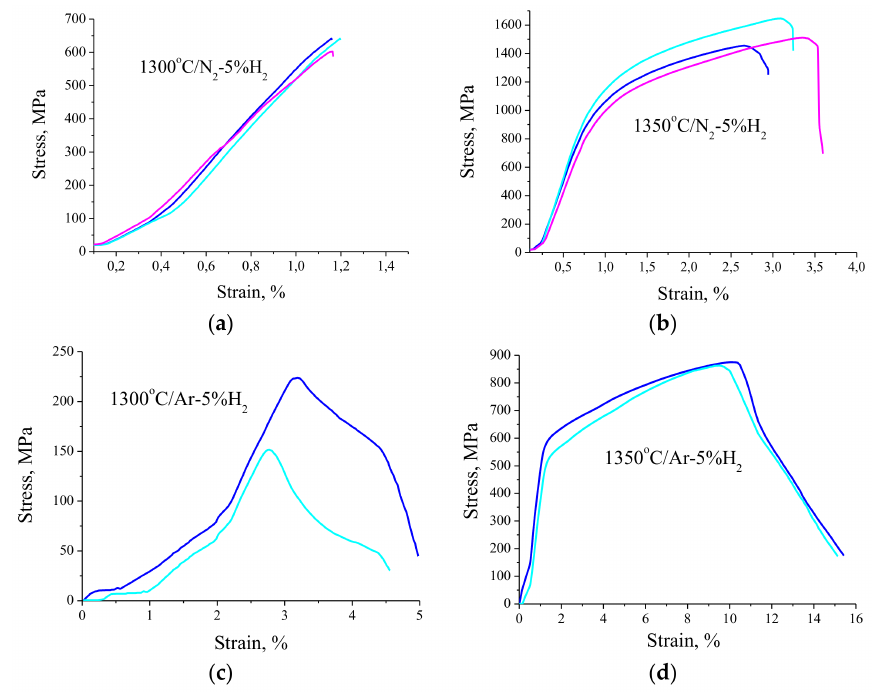
Figure 11. ( a ) Three-point bending tests for samples after debinding under N 2 and sintering at 1300 ◦ C under N 2 -5%H 2 ; ( b ) Three-point bending tests for samples after debinding under N 2 and sintering at 1350 ◦ C under N 2 -5%H 2 ; ( c ) Three-point bending tests for samples after debinding under Ar-5%H 2 and sintering at 1300 ◦ C under Ar-5%H 2 ; ( d ) Three-point bending tests for samples after debinding under Ar-5%H 2 and sintering at 1350 ◦ C under Ar-5%H 2.